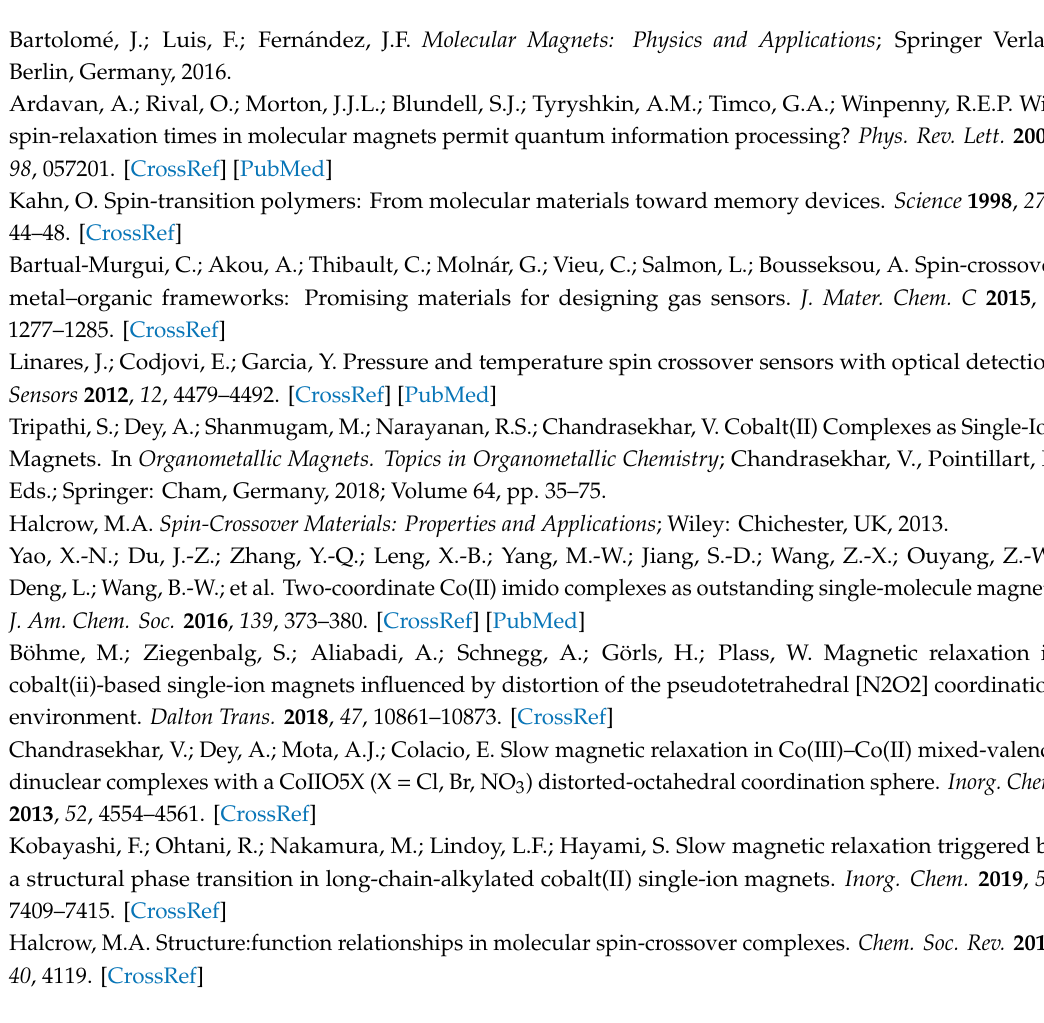
Figure S1: In-phase χ real and out-of-phase χ imag molar susceptibilities for 2 at zero static magnetic field and in non-zero static field. Table S1: Parameters of one-component Debye model for 2 derived according Eq.4 in main text. Table S2: The g-values for the ground state Kramers doublet calculated for the e ff ective spin S e ff = 1 / 2 for 2 derived from CASSCF / NEVPT2 calculations. CCDC 1972873-1972874 contain the supplementary crystallographic data for this